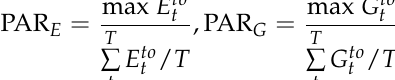
Figure 9. Hourly energy supply and demand of the whole energy system.